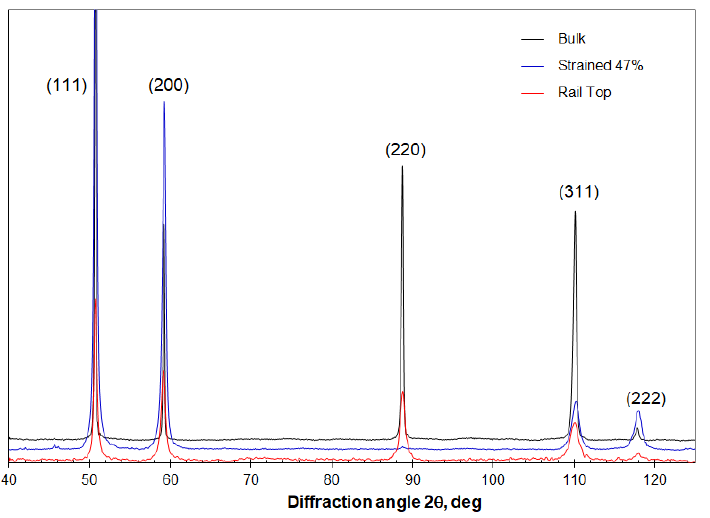
Figure 3. The X-ray diffraction curves of the Hadfield steel under various strained conditions, showing different broadening of the austenite diffraction peaks.